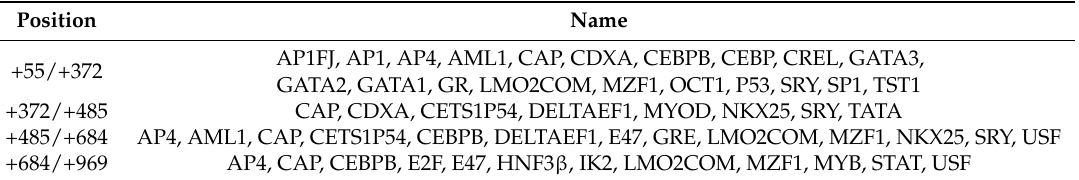
Table 1. The potential transcriptional factor binding sites (TFBSs) in chicken growth hormone ( cGH ) intron 1